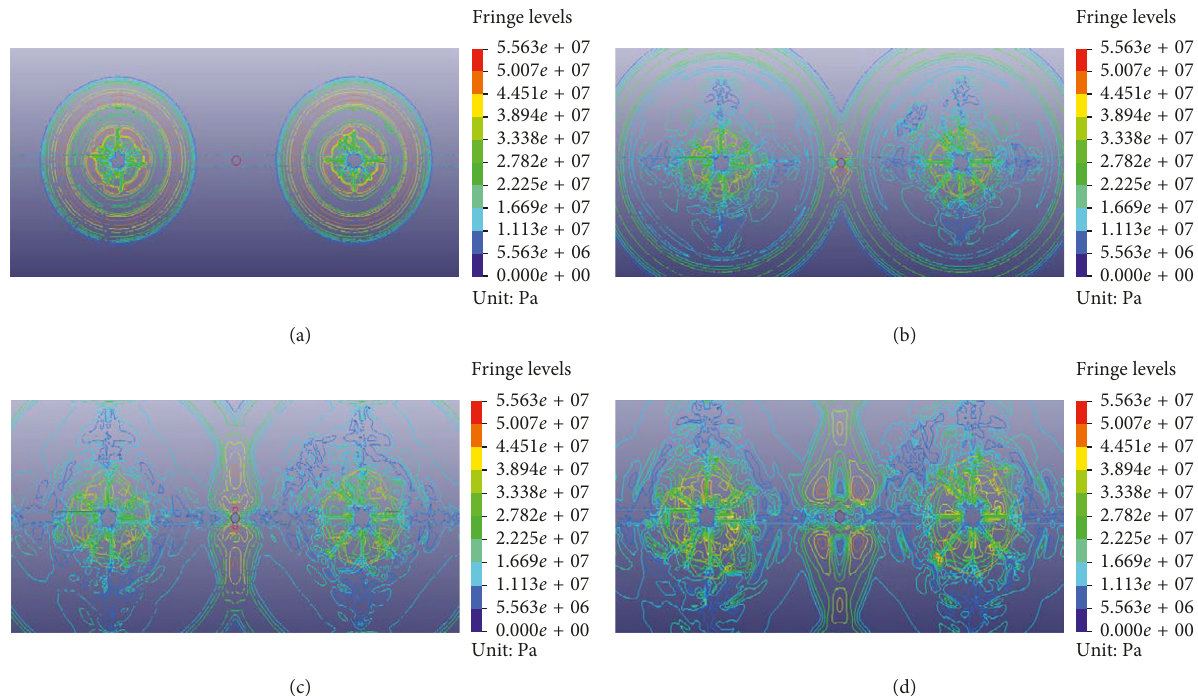
Figure 13: Fringe patterns of equivalent stress. (a) 109.3 μ s. (b) 199.2 μ s. (c) 449.8 μ s. (d) 552.5 μ